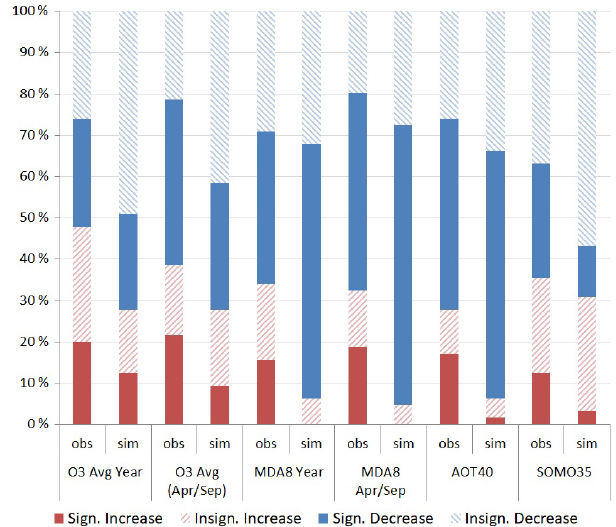
Figure 11. Percentage of sites where statistically significant up- ward trends (dark red), non-significant upward trends (hatched dark red), significant downward trends (dark blue), and non-significant downward trends (hatched dark blue) were obtained for different observed and simulated metrics for O 3